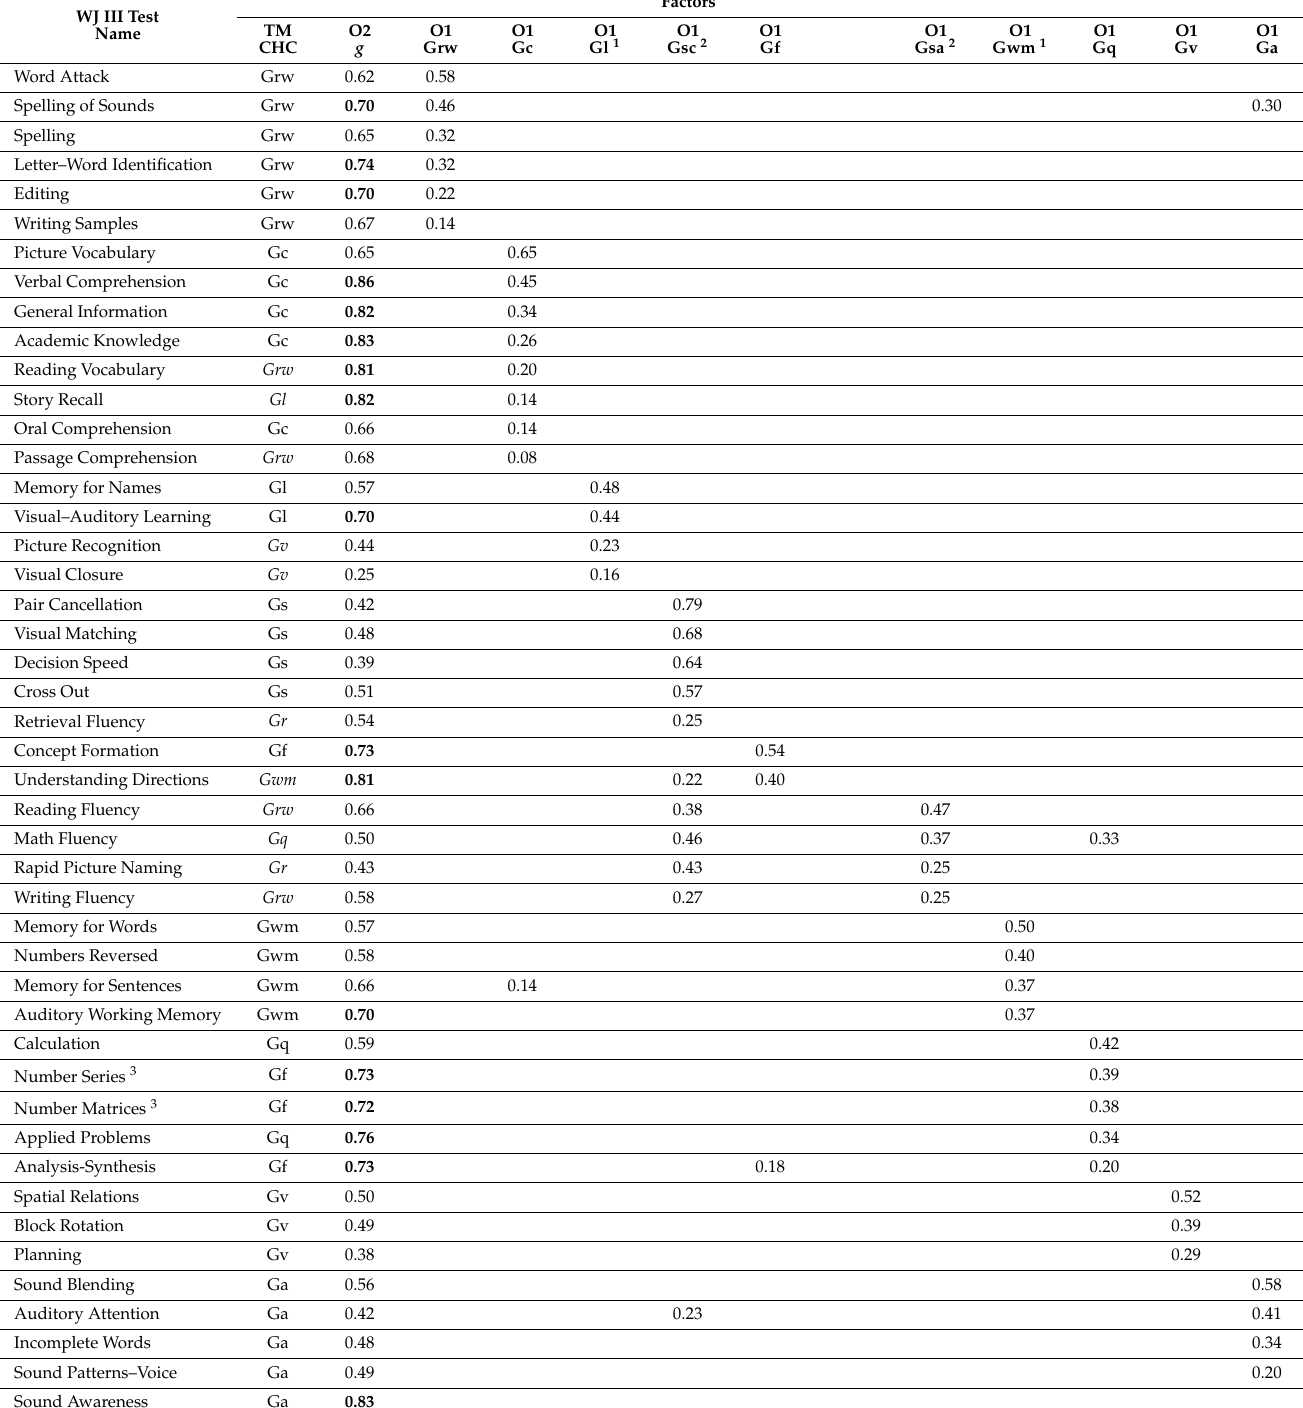
Table 1. Bifactor CFA of WJ III 46 Tests Based on Carroll Exploratory Factor Analysis. Note. TM CHC = CHC classifications from WJ III technical manual. Italic font indicates different CHC factor classification based on the analysis. The 1st-order factor names are as per Schneider and McGrew (2018). O1 and O2 designate 1st- and 2nd-order factors as per Carroll’s EFA-SL software (see Supplementary Materials Section S3. Bold designates test g loadings of .70 or above. 1 Original WJ III Glr classification changed to Gl or Gr and Gsm changed to Gwm as per Schneider and McGrew (2018). 2 Gsc = processing speed–cognitive; Gsa = processing speed–achievement. 3 Number Series and Number Matrices subtests were combined as a single Numerical Reasoning test in the WJ